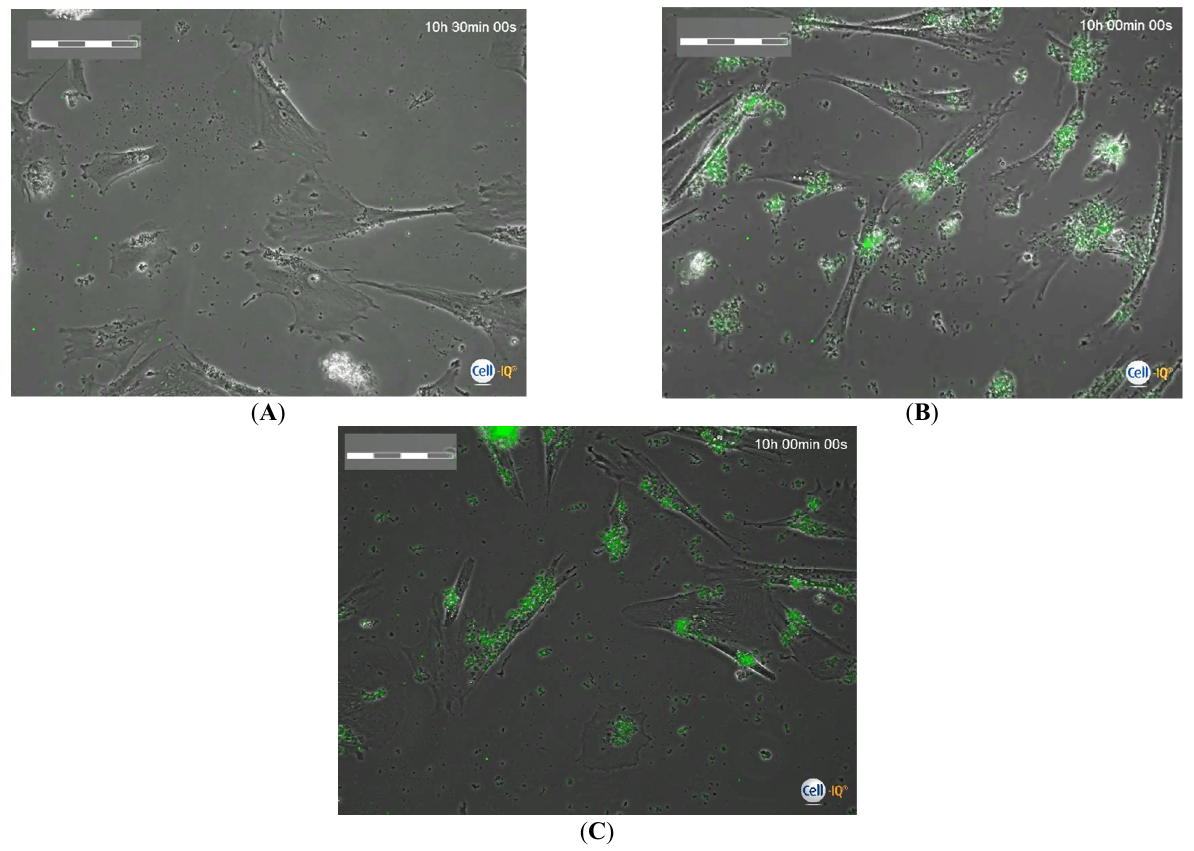
Figure 2. Phase contrast Cell-IQ monitoring of hAMSCs state within 10 h after 24 h phagocytosis of FITC-labelled microcapsules in dependence to the calculated number of vehicles in the intercellular medium. ( A )—Control cells without capsules; ratio of cells to capsules: ( B )—1:45; ( C )—1:90. Scale bar is 200 µm.